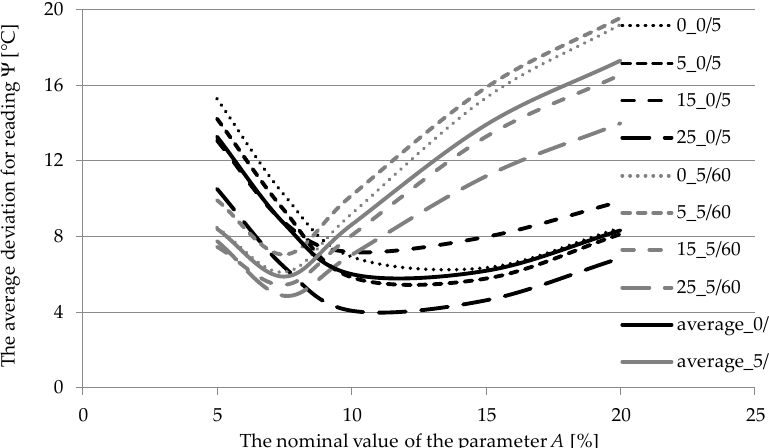
The nominal value of the parameter A [%] Figure 12. The mean absolute deviation Ψ between the measured and theoretical temperatures for HMA specimens depending on the value of A and the ambient air temperature for 0–5 min. and 5–60 min. time spans.